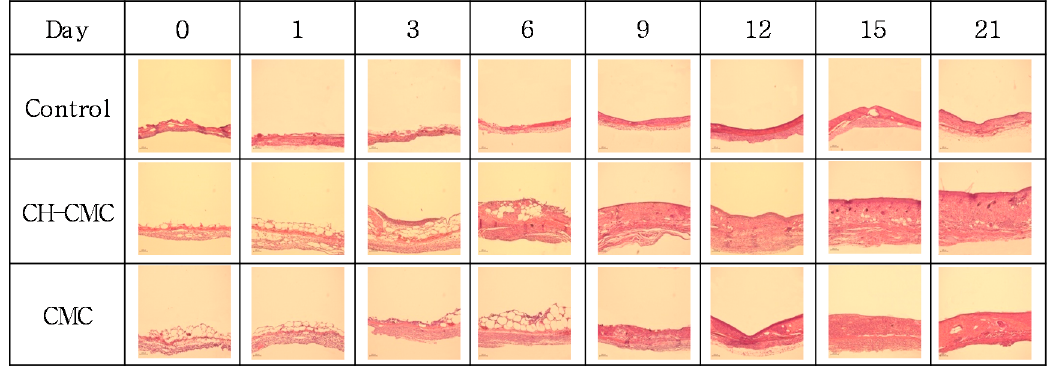
Figure 8. Histology image of granulation tissue in the wound by dates on consecutive days; control (non-treated wound), CH–CM (CH–CMC hydrogels treated wound), CMC (CMC hydrogels treated wound).